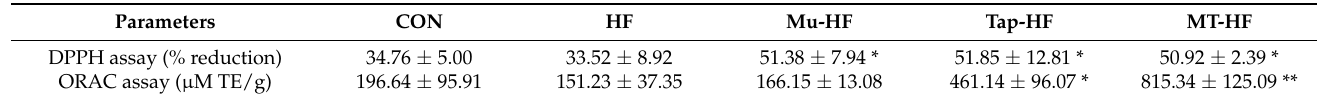
Figure 3. Inflammatory markers in liver tissue of rats with high-fat diet supplemented with murici and tapereba fruit-based beverages. ( A ) Interleukin-1 beta (IL-1 β ). ( B ) Tumor necrosis factor- α (TNF- α ). CON = control group; HF = high-fat group; Mu-HF = murici beverage group; Tap-HF = tapereba beverage group; MT-HF = murici and tapereba blend group. All values are expressed as mean ± SD. n = 4 to 10 per group. Means with different letters are significantly different ( p < 0.05, Tukey’s test).